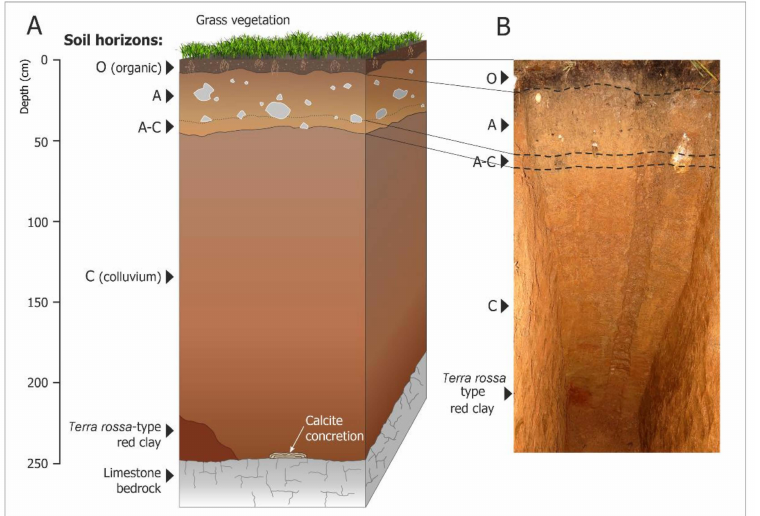
Figure 4. Schematic representation of the soil profile ( A ) and actual image of the profile ( B ). Due to the narrow dimensions of the excavation, a complete view of the profile could be seen only in perspective, hence the differences from the schematic representation which is based on measurements. A terra rossa-type soil remnant could be seen in the lower part of the profile, as well as a calcite concretion that was formed in contact with the underlying